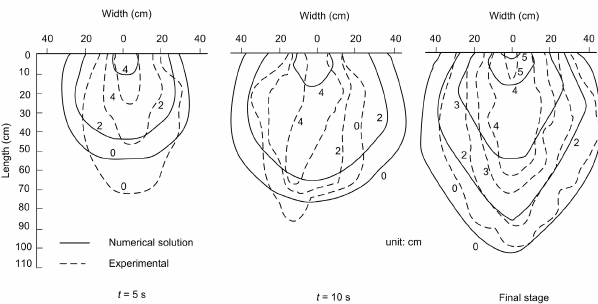
Figure 12. Comparison of the time-varying geometry and eleva- tions of the debris fan in Test 4 from the numerical solution and the experimental